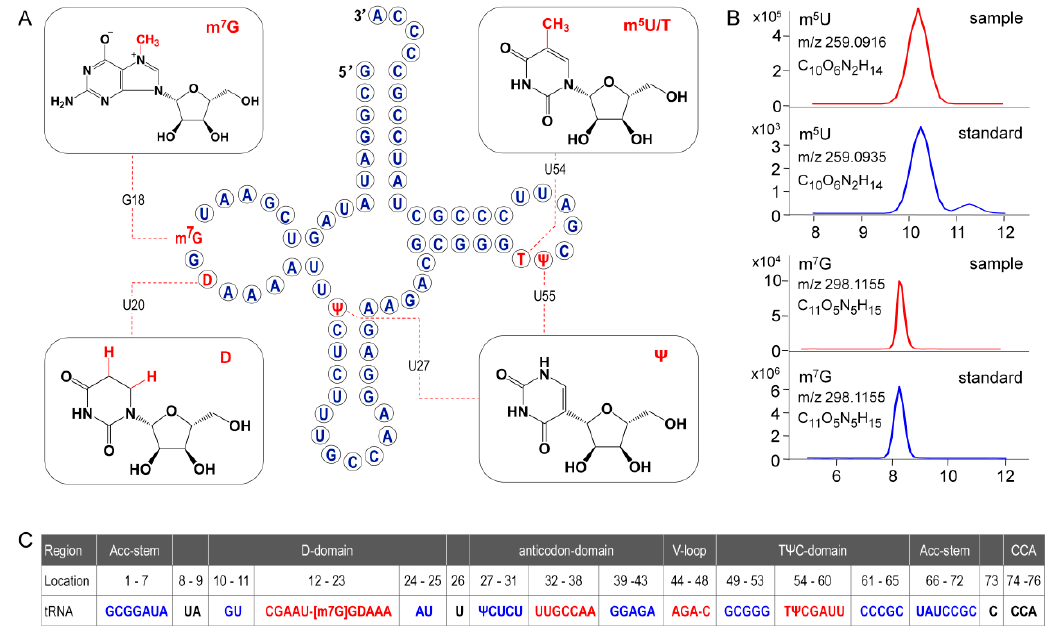
Figure 8. ( A )Secondary structure of ginseng chloroplastictRNA Gly(GCC) . Modified nucleosides are indicated in red. ( B ) Position isomers of monomethylated G and U are identified based on their retention times in standard UHPLC separation system. ( C ) Formating and numbering of nucleotides in tRNA Gly(GCC) have been done in accordance with Sprinzl et al. [24]. Stems are highlighted in blue and loops are indicated in red. Positions 17 and 47, which are empty, are indicated by dashes.